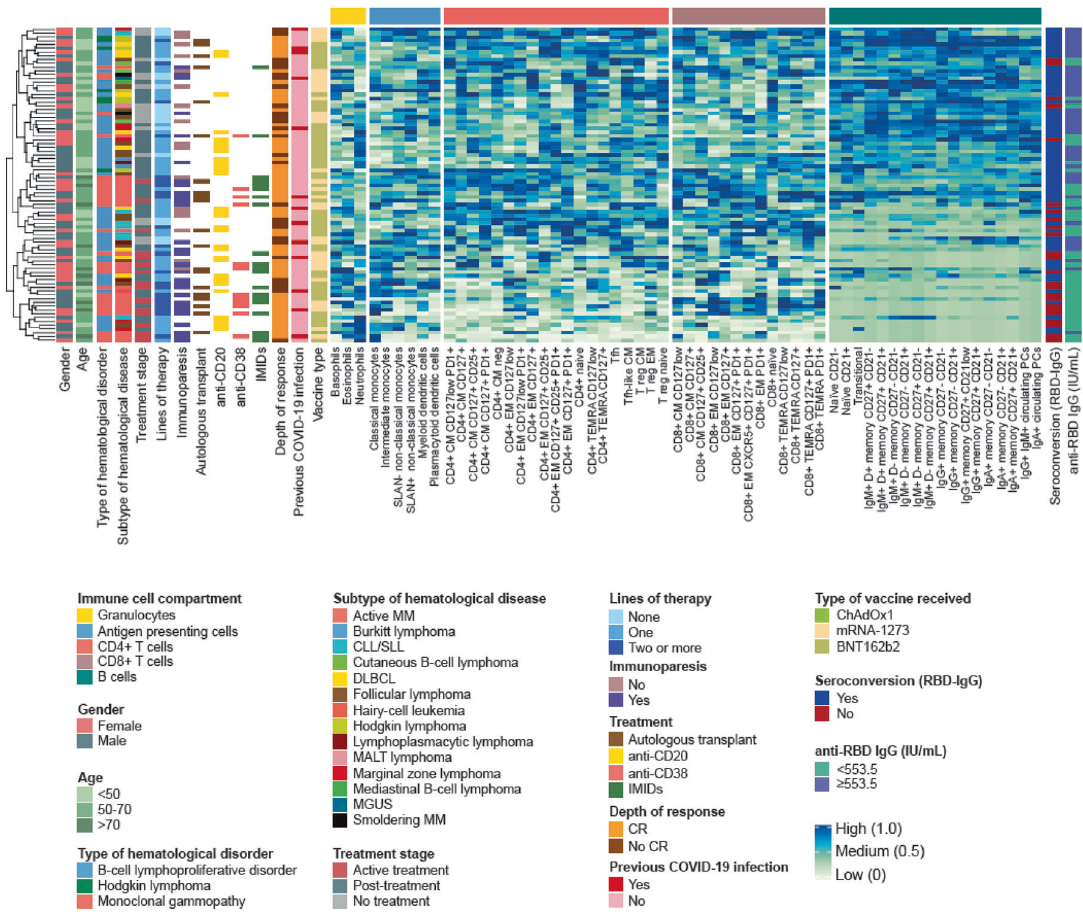
Fig. 5 Immunotypes associated with poor antibody response. Unsupervised clustering of 83 hematological patients and 102 health care practitioners (HCPs) based on the relative percentile distribution of 59 immune cell types in peripheral blood before vaccination, categorized into four groups: granulocytes, antigen-presenting cell (APC) subsets, T-cell and B-cell subsets. For the columns to the left of the cell- percentage data, moving from left to right, rows are color-coded according to gender, age groups, type and subtype of hematological malignancy, treatment status, number of previous lines of therapy, immunoparesis, autologous transplant, treatment with anti-CD20 antibodies, anti-CD38 antibodies and immunomodulatory drugs (IMiDs), depth of response to treatment (complete remission, CR), previous SARS-CoV-2 infection, and vaccine type. For the columns to the right of the cell-percentage data, moving from left to right, rows are color- coded according to seroconversion and presence of ≥ 553.5 IU/mL IgG against the receptor-binding domain (RBD) of the S-glycoprotein. CM, central memory; EM, effector memory; Treg, T regulatory cells; Tfh, T follicular-like; TEMRA, terminally effector memory CD45RA + ; PC, plasma